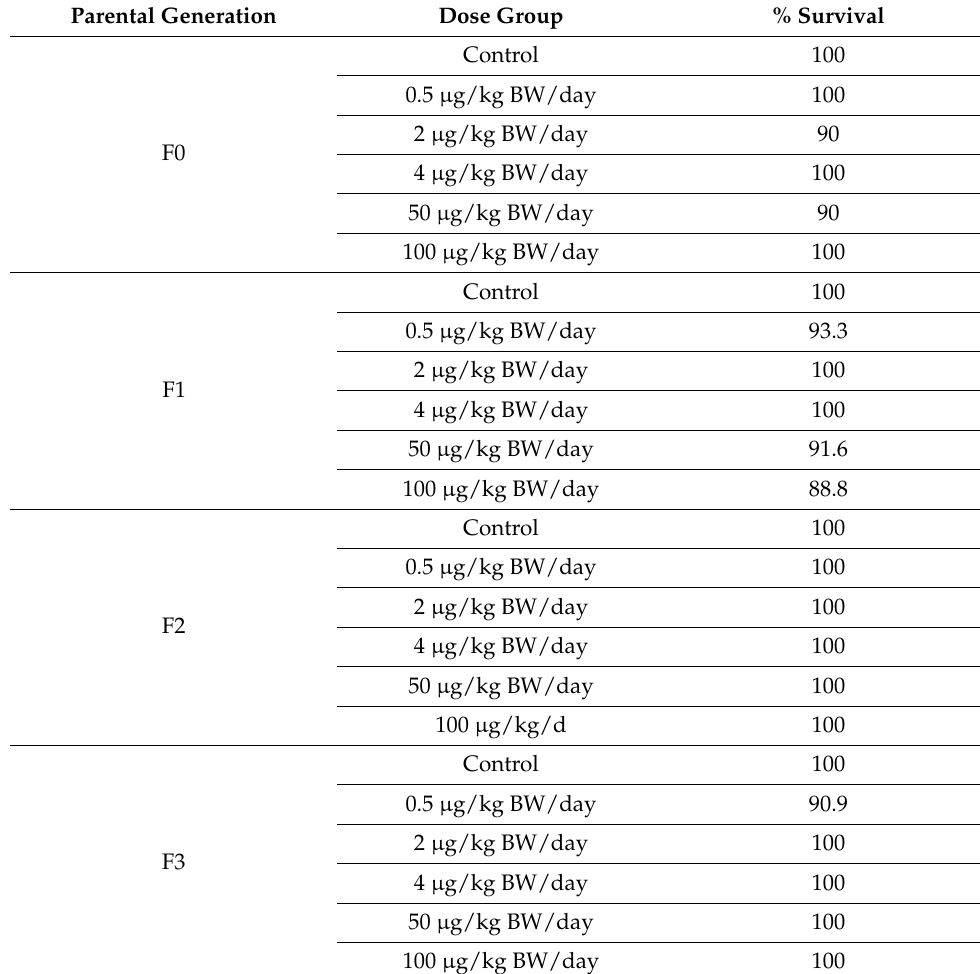
Table 2. Percentage of pups that reach weaning alive by exposure group and parental generation. Parental Generation Dose Group %